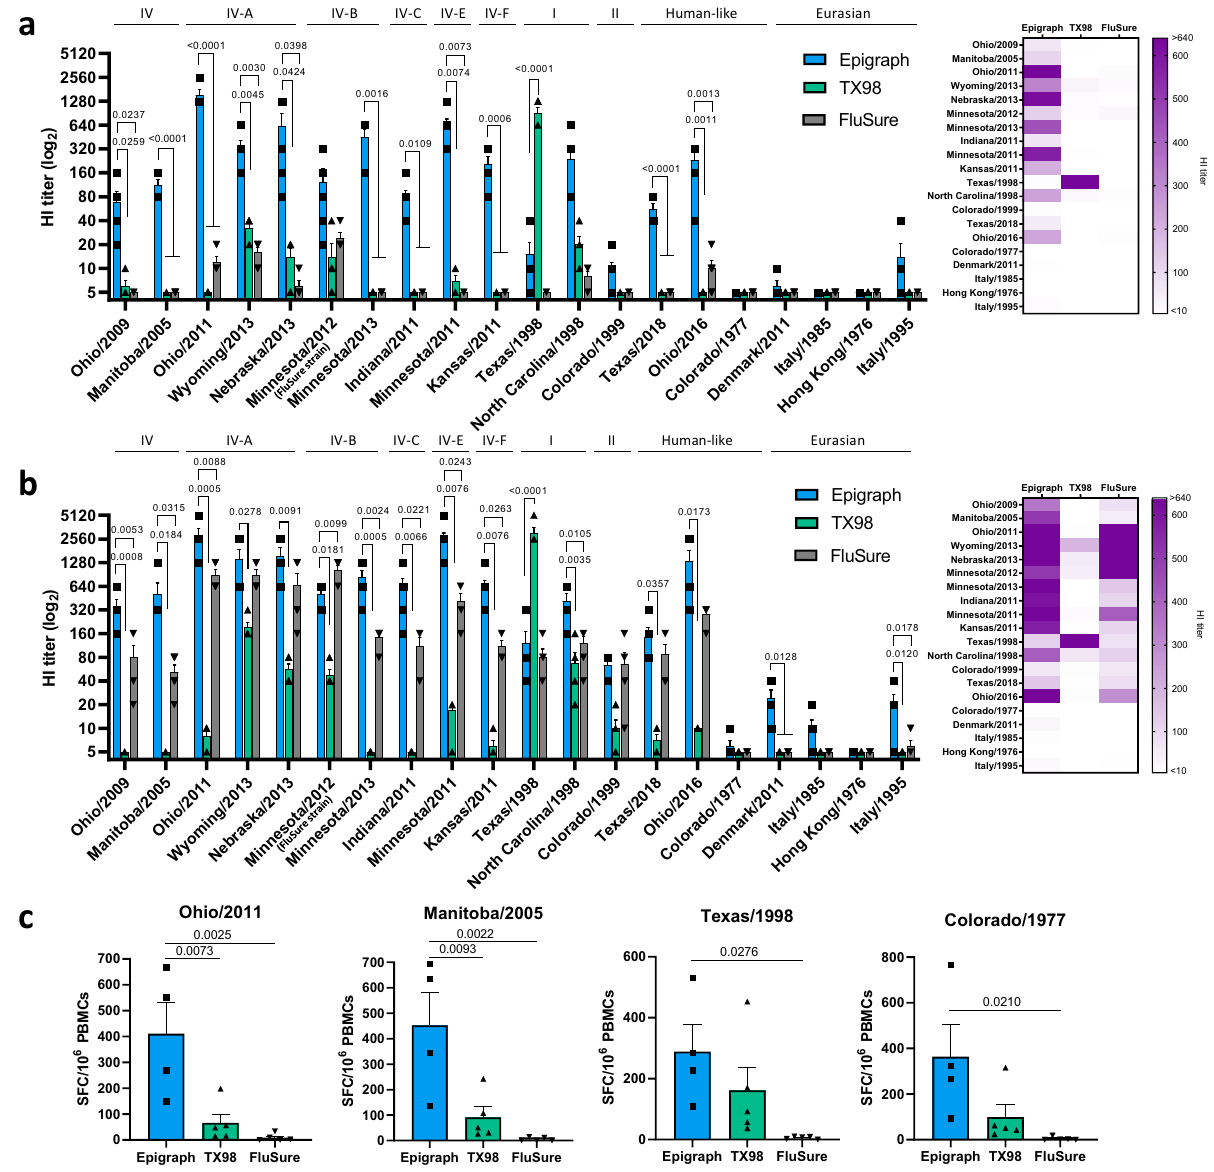
Fig. 6 Immune responses to swH3 strains after vaccination in swine. To con fi rm that the cross-reactive immune responses observed after epigraph vaccination in mice translated to the target animal, 3-week-old swine ( n = 5) were vaccinated with 10 11 vp of HAdV-5-epigraph or HAdV-5-TX98 or